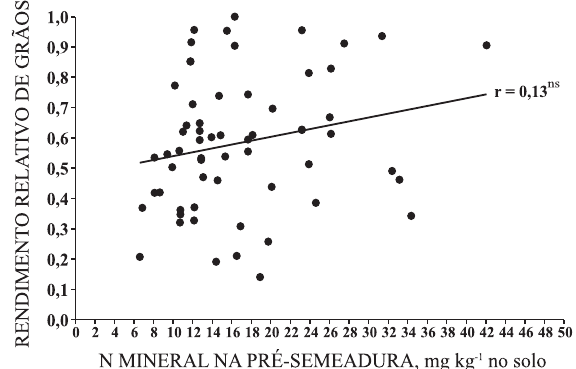
Figura 4. Correlação entre os teores de N mineral do solo na pré-semeadura e o rendimento relativo de grãos em 61 ensaios, no Rio Grande do Sul.